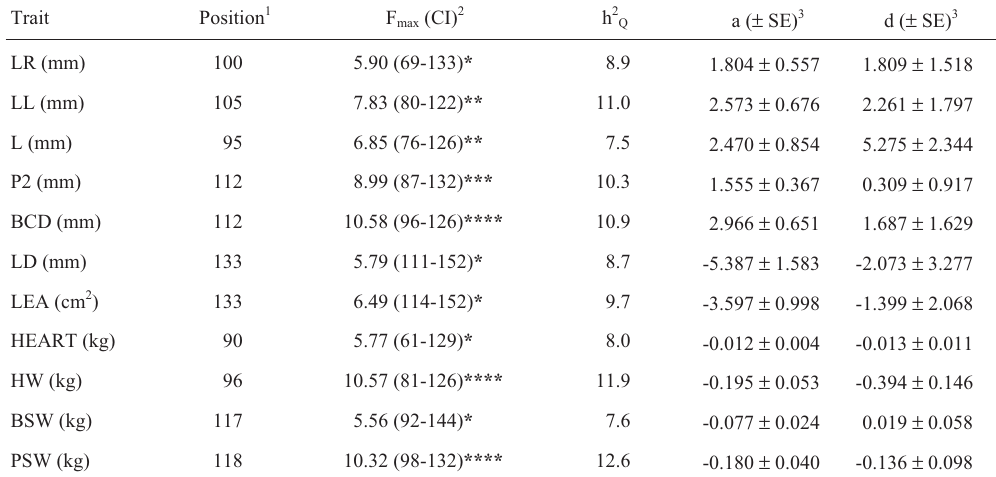
Table 2 - Summary of the QTL positions (cM), maximum likelihood ratios (F max ), phenotypic variance in F2 explained by the QTL (h 2 Q ) in percentage and the respective estimates of additive and dominance effects.